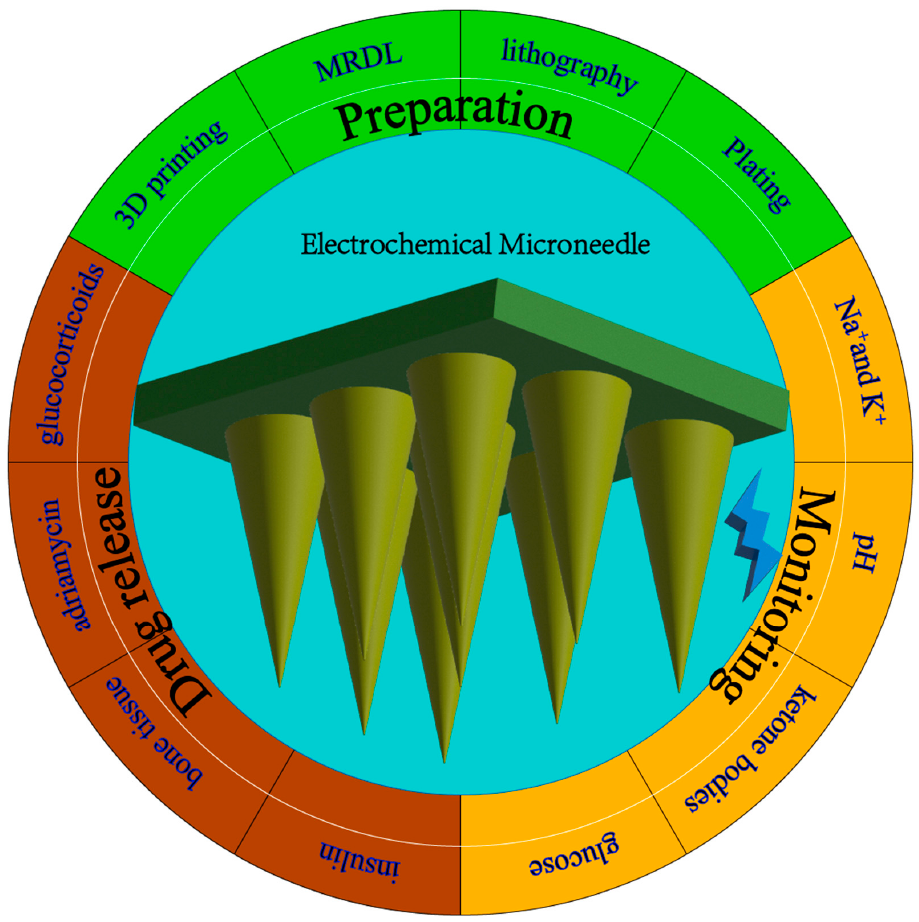
Figure 1. Electrochemical microneedles for healthcare.